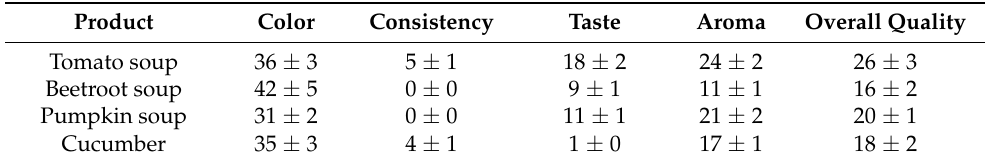
Table 7. Changes of sensory attributes (%) after rehydration of freeze-dried soups in comparison to freshly prepared